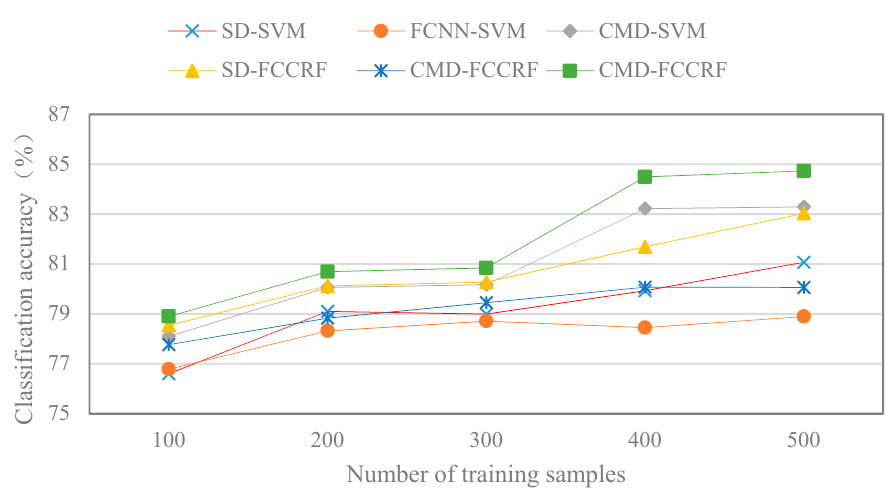
Figure 5. Effect of training data size on the classification results.